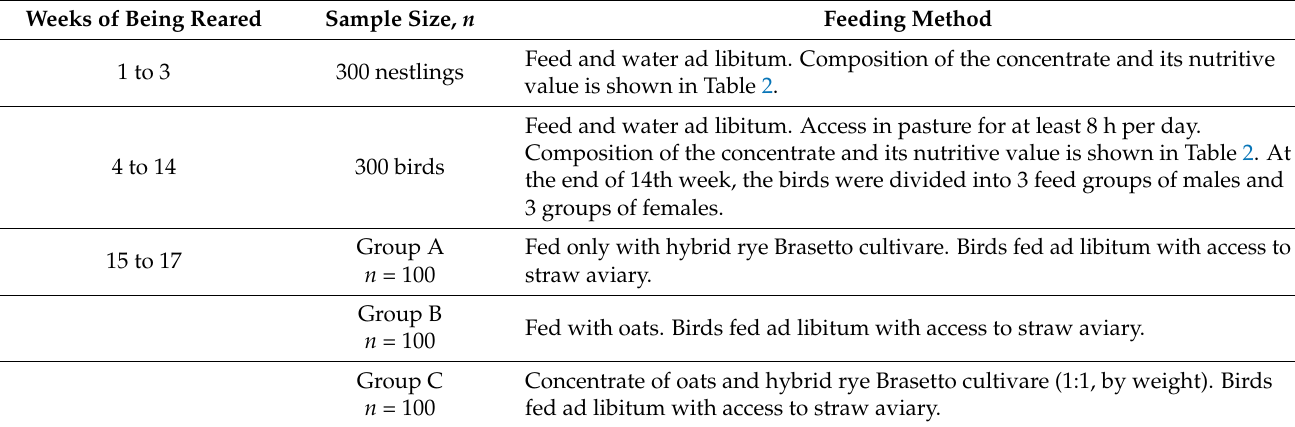
Table 1. The experimental plan of the Zatorska geese breed fed with different kinds of cereals. Weeks of Being Reared Sample Size, n Feeding Method Feed and water ad libitum. Composition of the concentrate and its nutritive 1 to 3 300 nestlings value is shown in Table 2. Feed and water ad libitum. Access in pasture for at least 8 h per day. Composition of the concentrate and its nutritive value is shown in Table 2. At 300 birds the end of 14th week, the birds were divided into 3 feed groups of males and